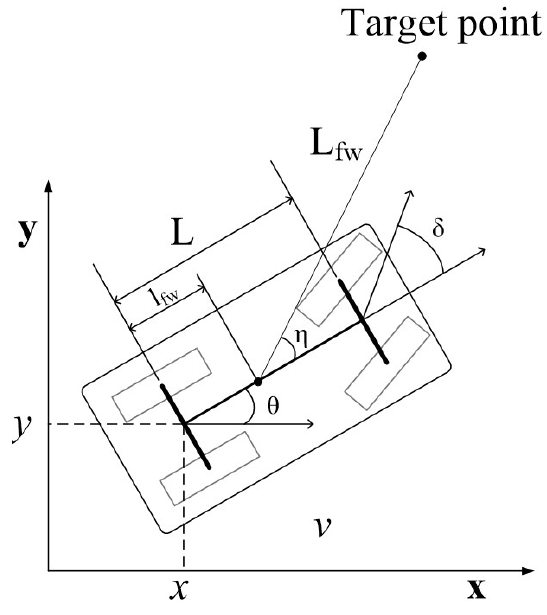
Figure 1. Geometry of the car-like mobile robot